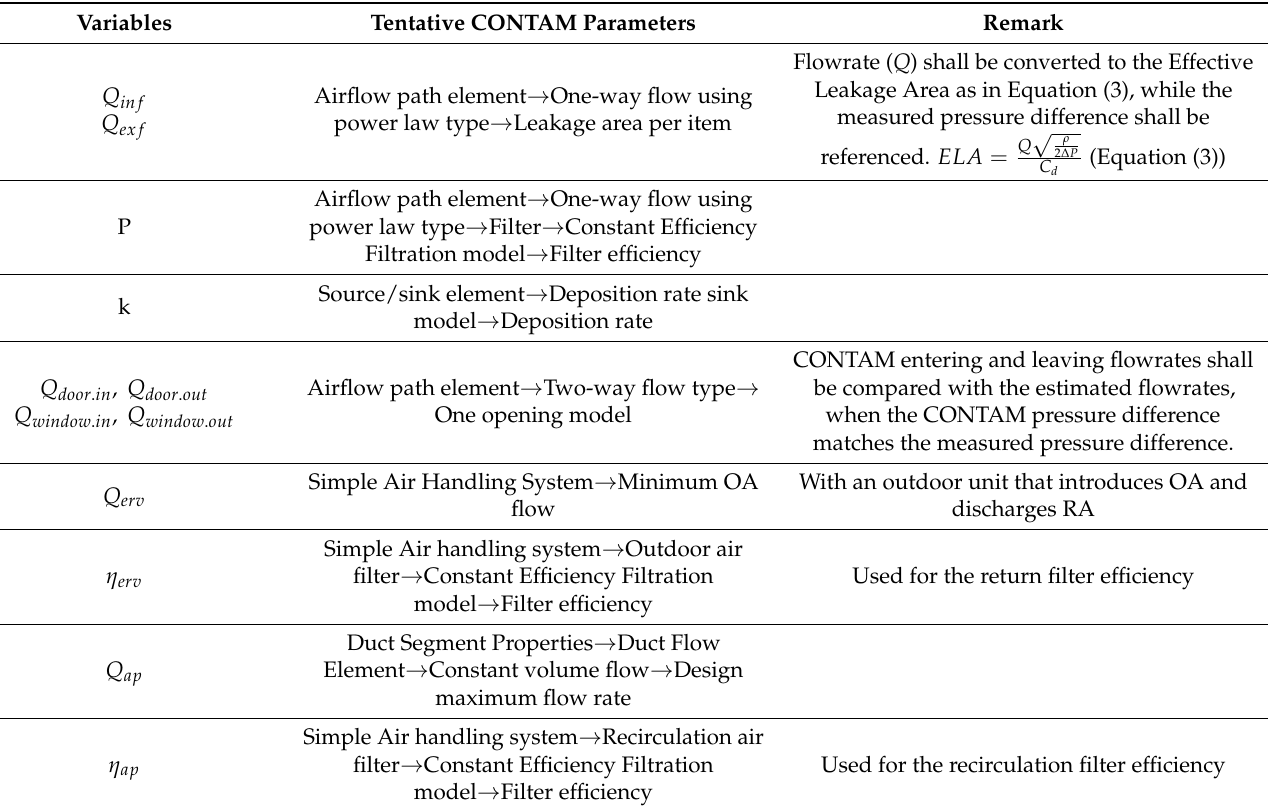
Table 7. CONTAM parameters that correspond to the control variables of the diagnostics